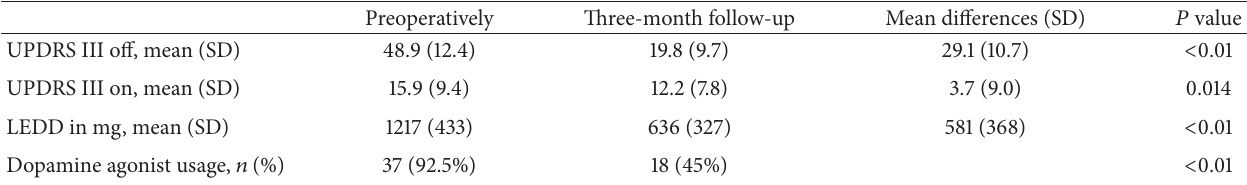
Table 2: Comparison of neurological measurements; Unified Parkinson’s Disease Rating Scale motor subscores (UPDRS-III), levodopa equivalent daily dose (LEDD), and dopamine agonist usage, preoperatively and after three months of